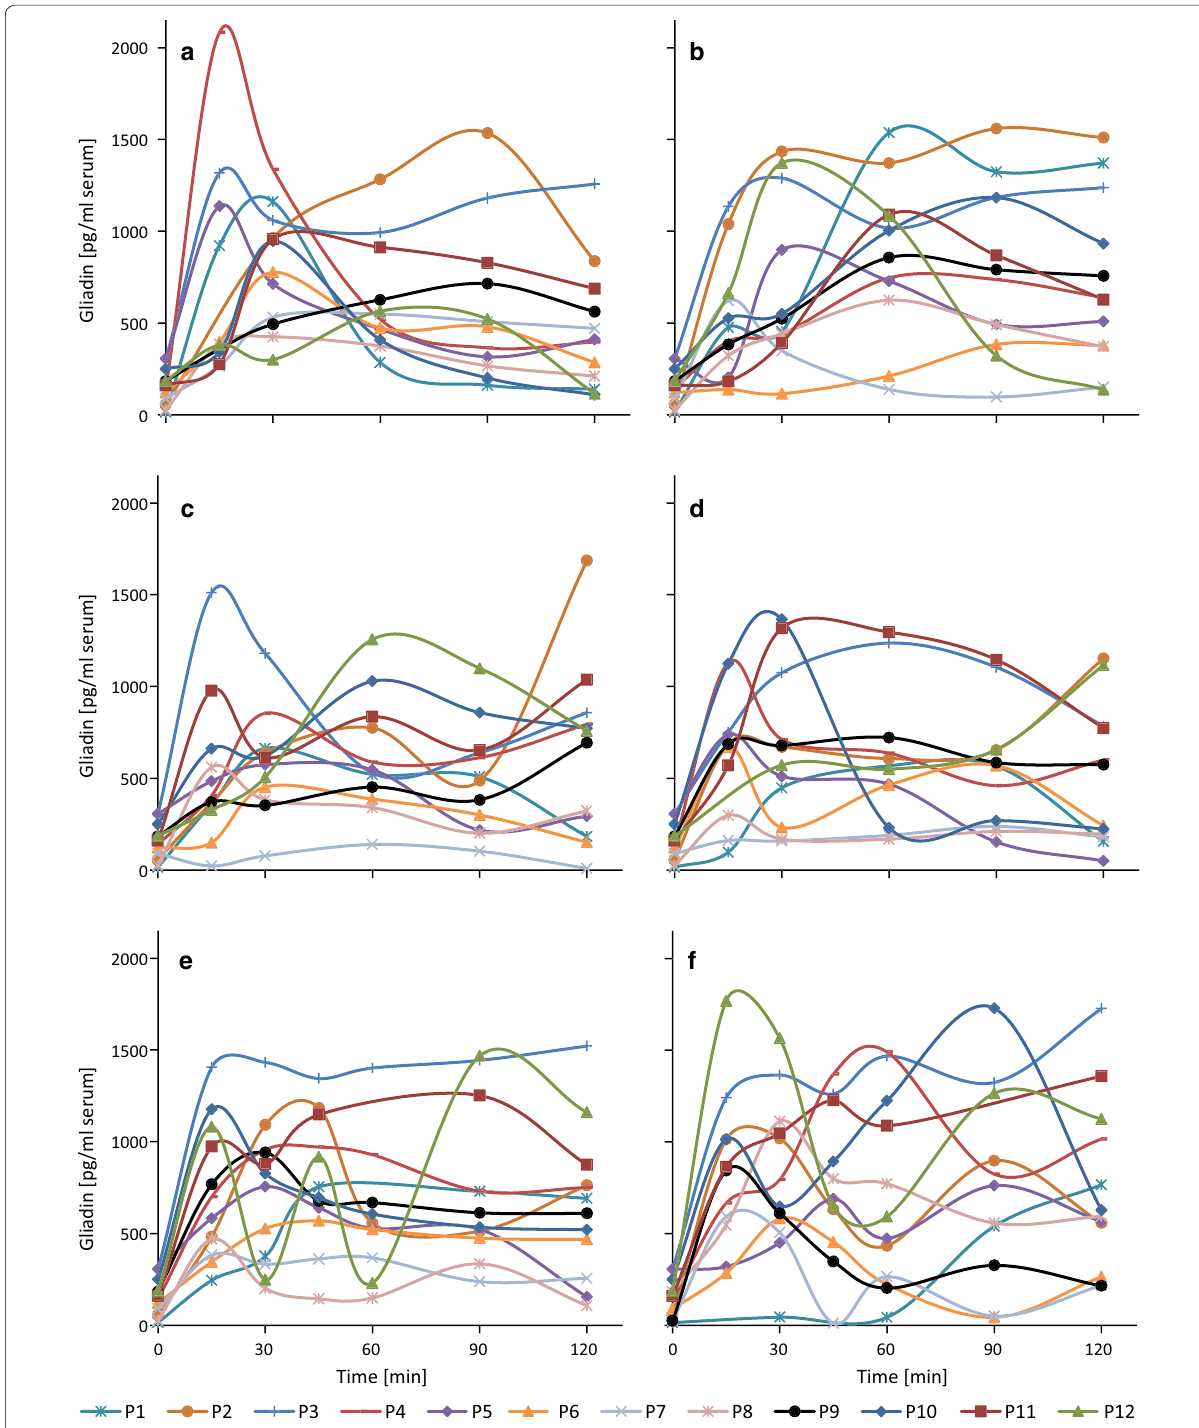
Fig. 2 Gliadin concentrations in blood serum after different interventions. Gliadin (pg/ml blood serum) after intervention with 32 g of gluten without cofactor ( a ) or with 32 g of gluten and different cofactors, proton pump inhibitor ( b ), acetylsalicylic acid ( c ), alcohol ( d ), aerobic exercise ( e ) or anaerobic exercise ( f ) in probands 1–12